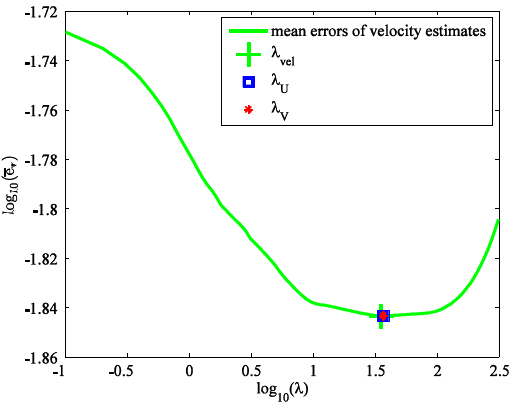
Figure 5. Mean errors of velocity estimates versus λ in logarithmic scale.